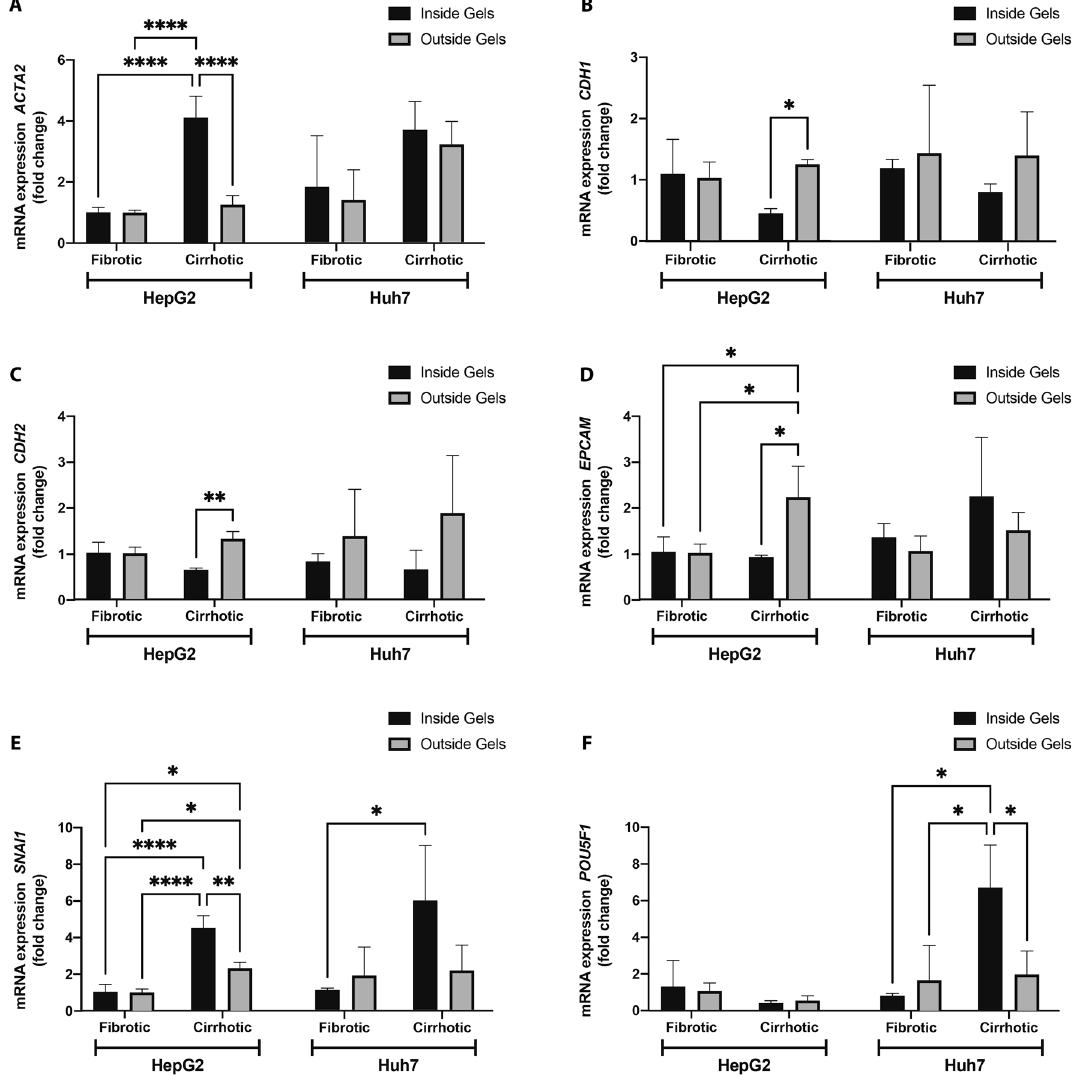
Figure 4. mRNA expression of EMT markers. ( A ) mRNA-expression of ACTA2 ( B ) CDH1 ( C ) CDH2 ( D ) EPCAM ( E ) SNAI1 and ( F ) POUF1 in HepG2 and Huh7 cells isolated from cells that appeared outside the gels and from cells that remained within the hydrogels (n = 3, error bars = SD, ****p < 0.0001, **p < 0.01, *p <